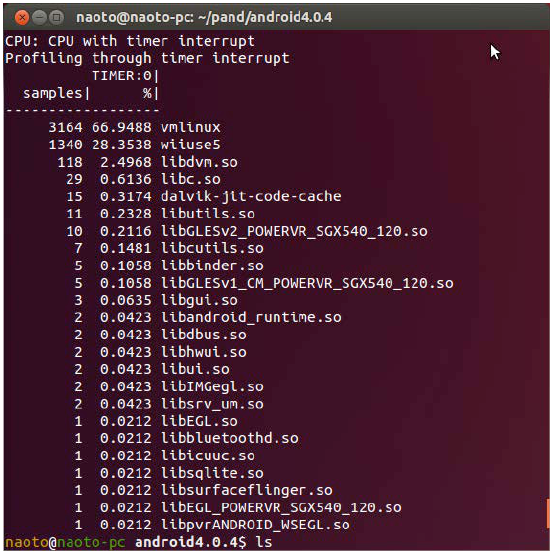
Fig. 10. OProfile result of virtual device method